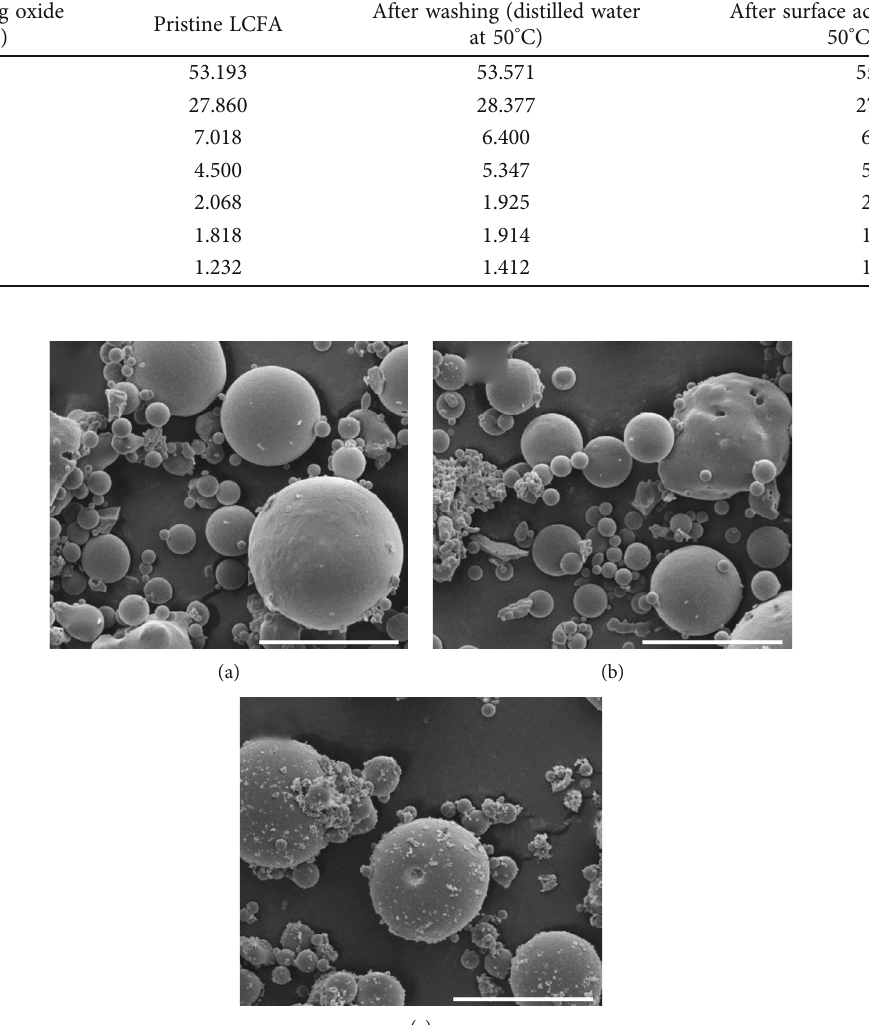
Figure 1: SEM images of (a) pristine LCFA, (b) activated LCFA, and (c) LCFA-APTES (scale bars: 20 μ m).